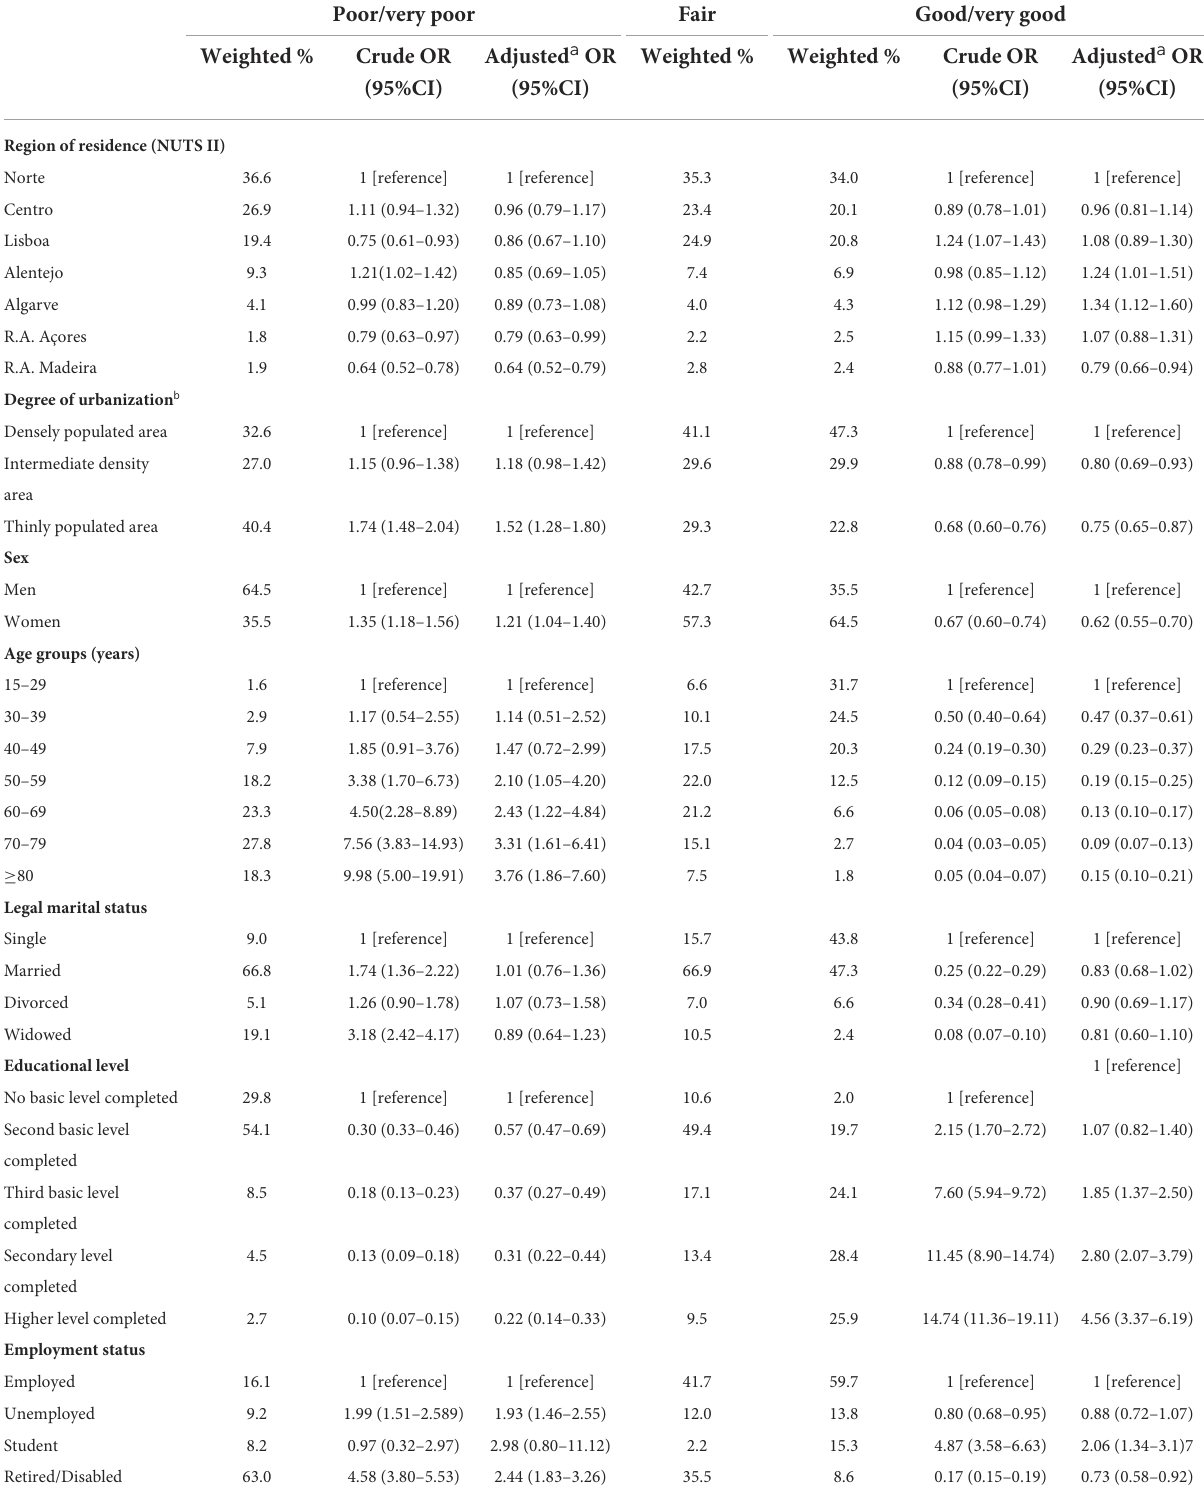
TABLE 2 Association between socio-economic characteristics and self-perceived health status. Self-perceived health status Poor/very poor Fair Good/very good Crude OR Weighted % Weighted % Adjusted a